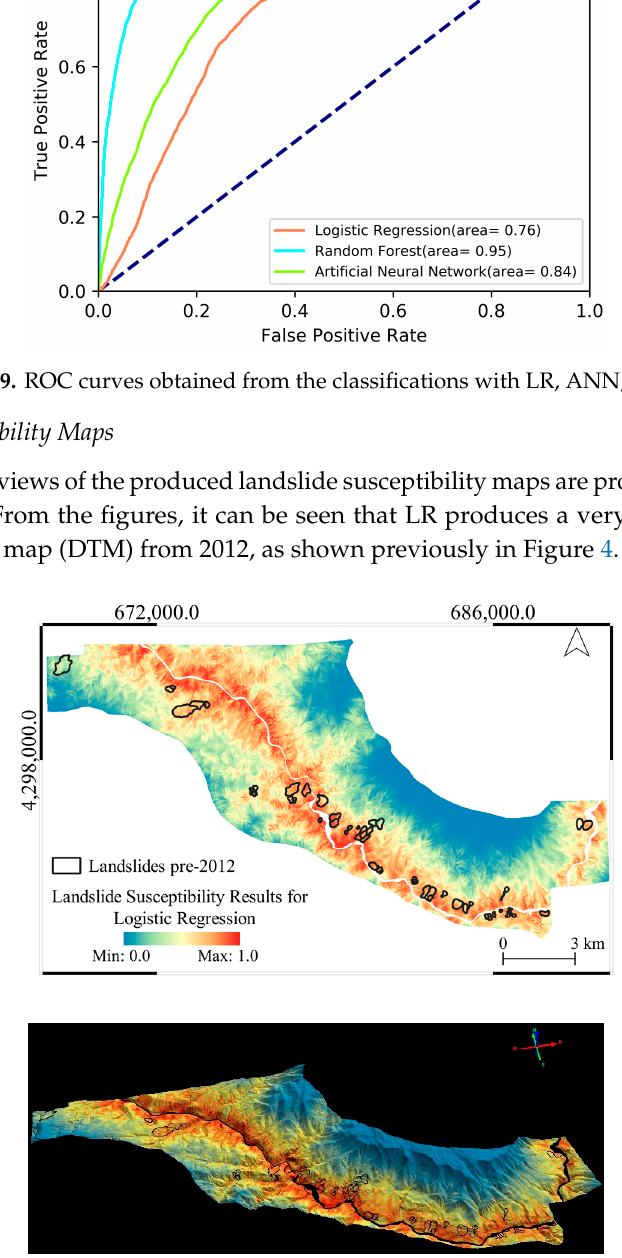
Figure 10. The landslide susceptibility map produced with the LR method in 2D (above) and 3D (below) visualization.